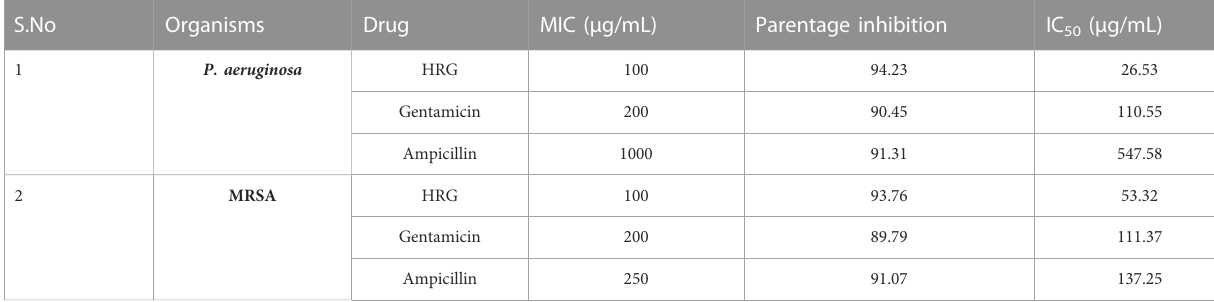
TABLE 2 Bio fi lm Evaluation of MIC, Percentage inhibition, and